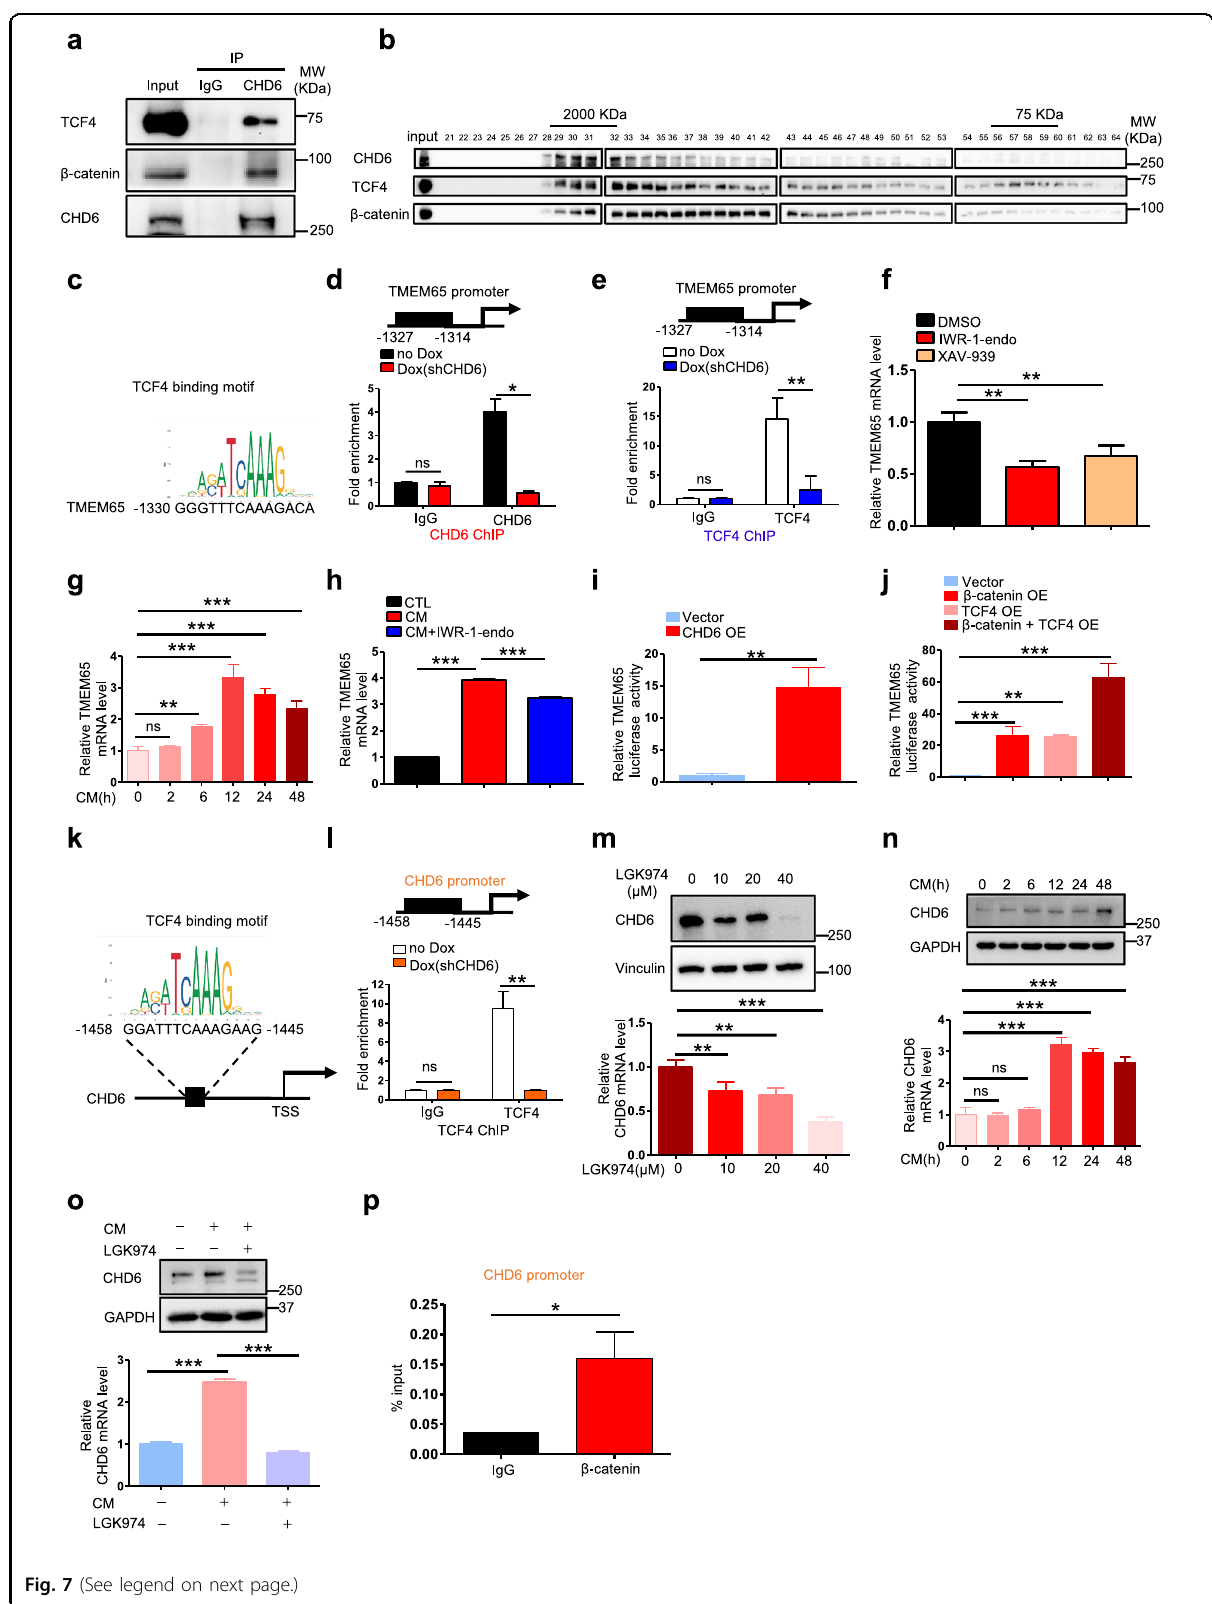
Fig. 7 (See legend on next